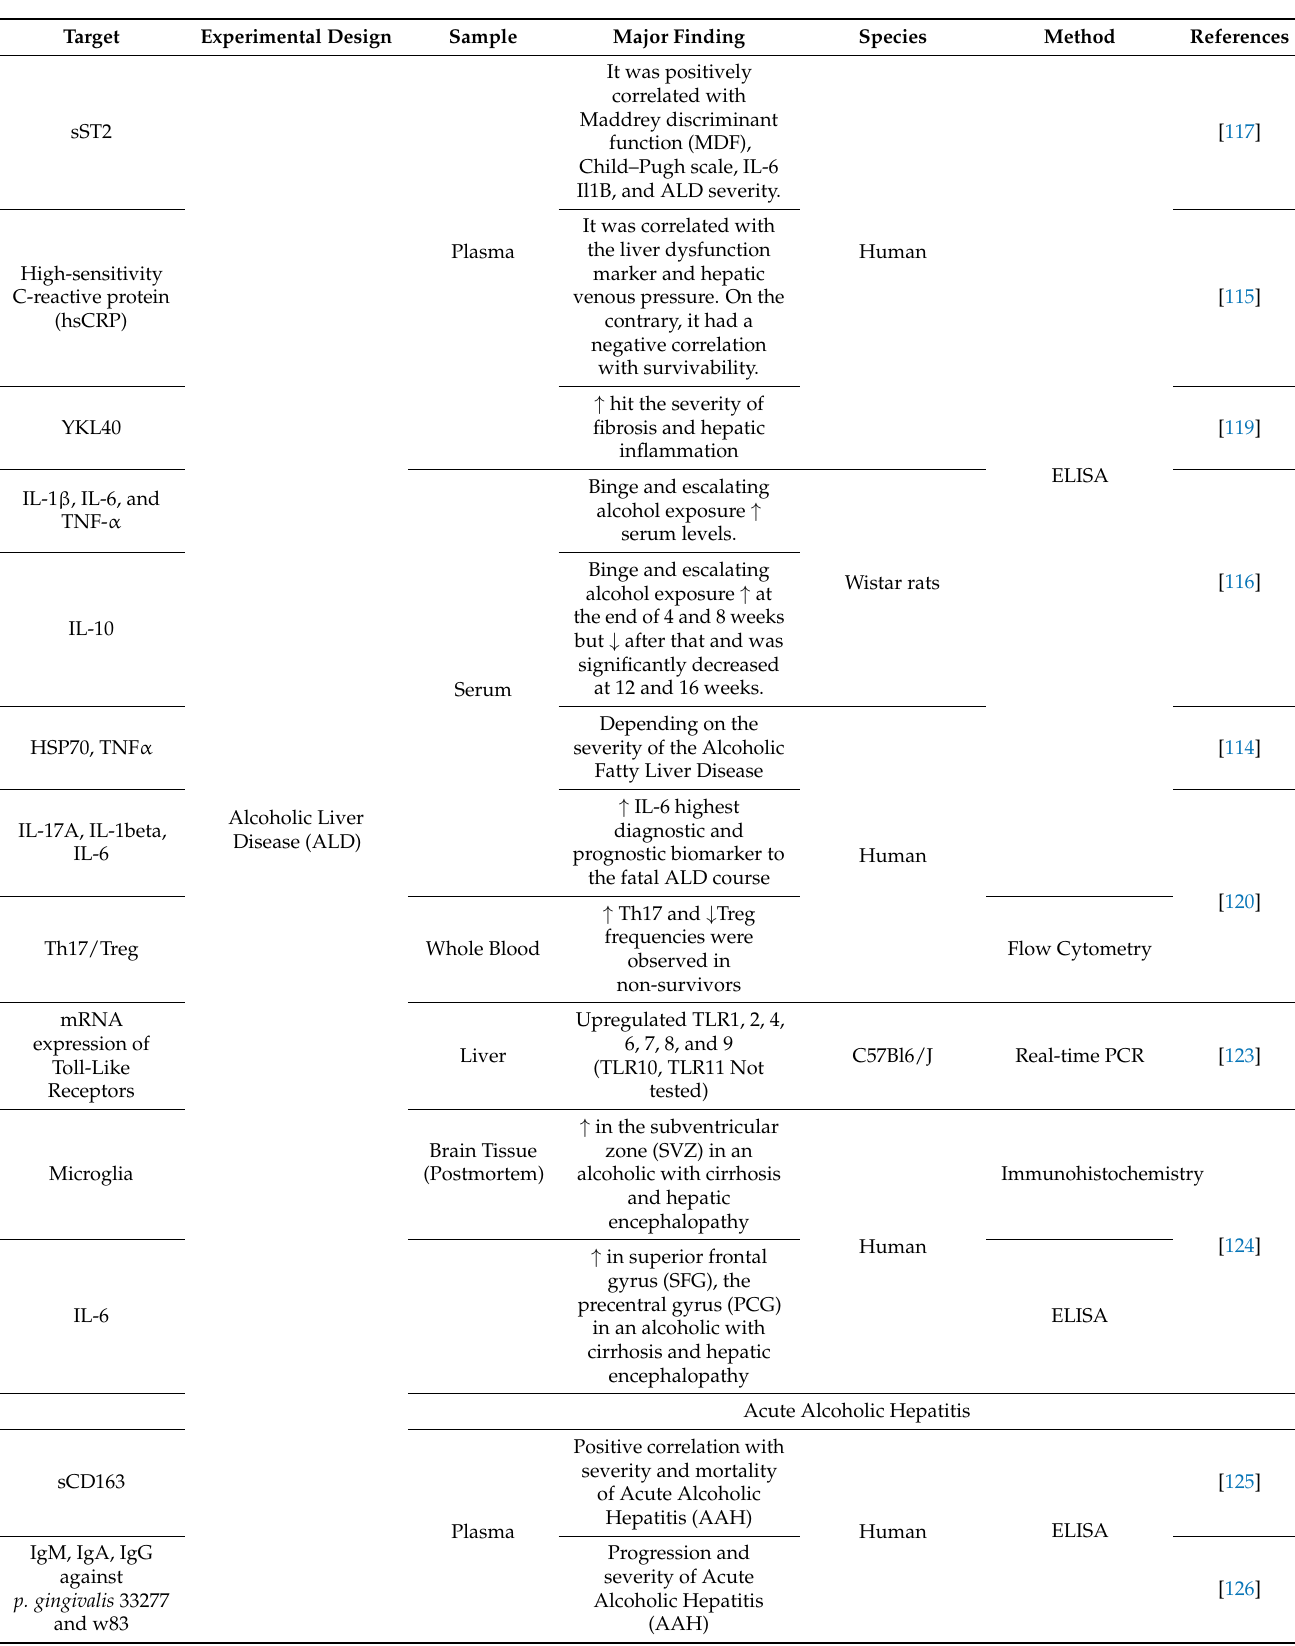
Table 5. Table: Alcoholic Liver